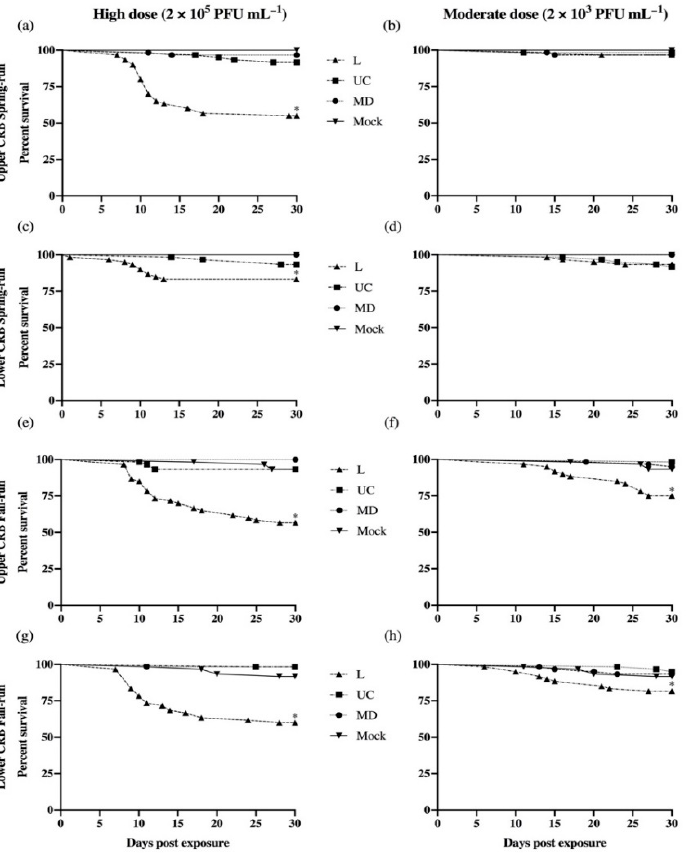
Figure 2. Daily cumulative percent survival of juvenile spring-run ( a – d ) and fall-run ( e – h ) Chinook salmon ( Oncorhynchus tshawytscha ) of the upper and lower Columbia River Basin (CRB) exposed to L, UC, and MD strains of infectious hematopoietic necrosis virus (IHNV) or virus-free media (Mock). Experimental host populations were exposed to each virus strain at high (left) and moderate (right) doses by static immersion in 1 L. Survival curves were constructed by pooling data from triplicate groups of 20 fish per treatment. Asterisks indicate that fish in the positive control L genogroup (FR0031) IHNV treatment had significantly lower survival than fish in the other viral strain treatments ( p < 0.001). No significant differences were observed between the MD and UC virus treatments within or across host populations.